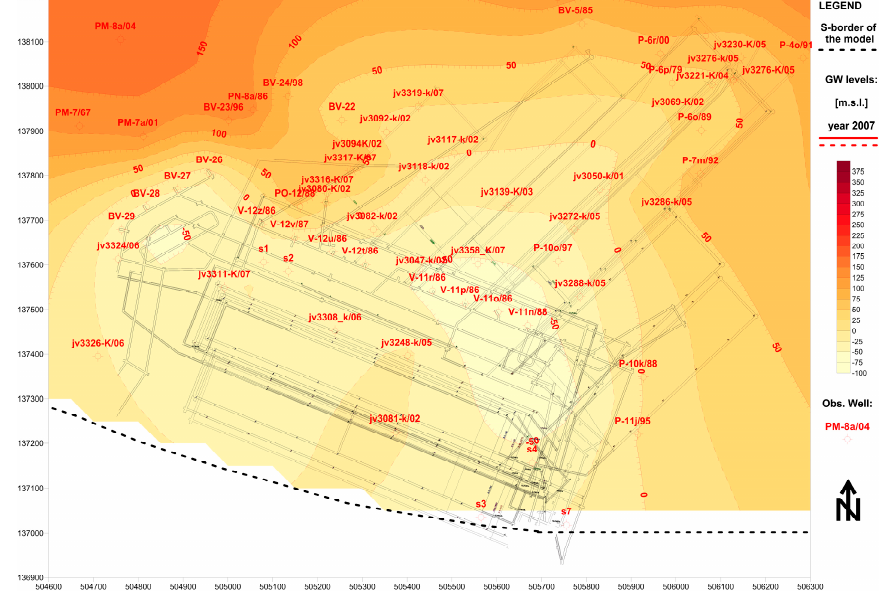
Figure 4. A groundwater levels map of the Pl ‐ 1 and Pl ‐ 2 variety of Pliocene water ‐ carrying sands in the year 2007.